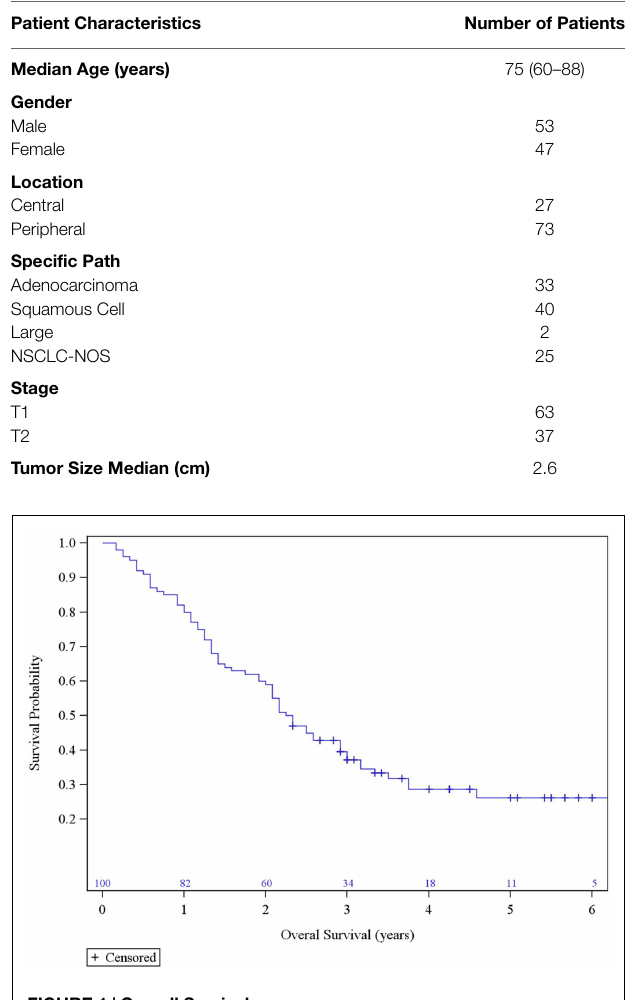
FIGURE 1 | Overall Survival .